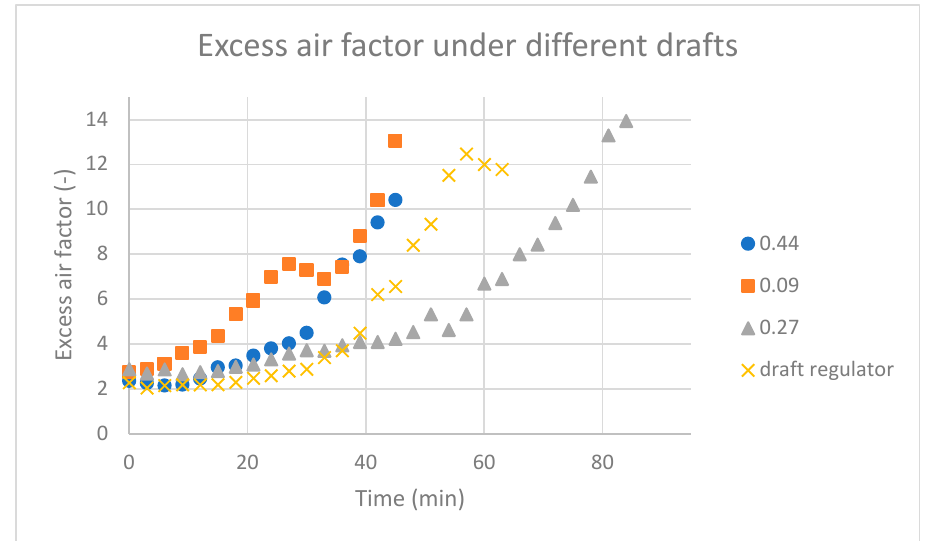
Figure 8. Excess air factor under different drafts.